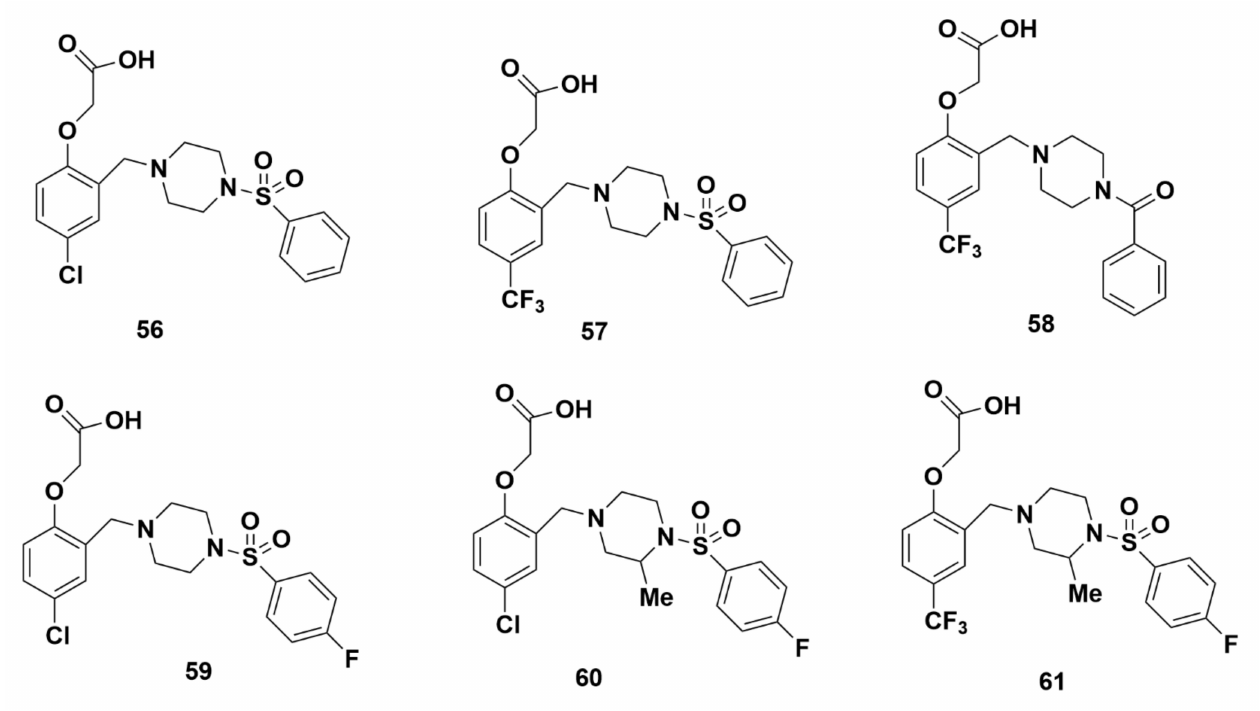
Figure 13. Molecular structures of compounds 56 – 61